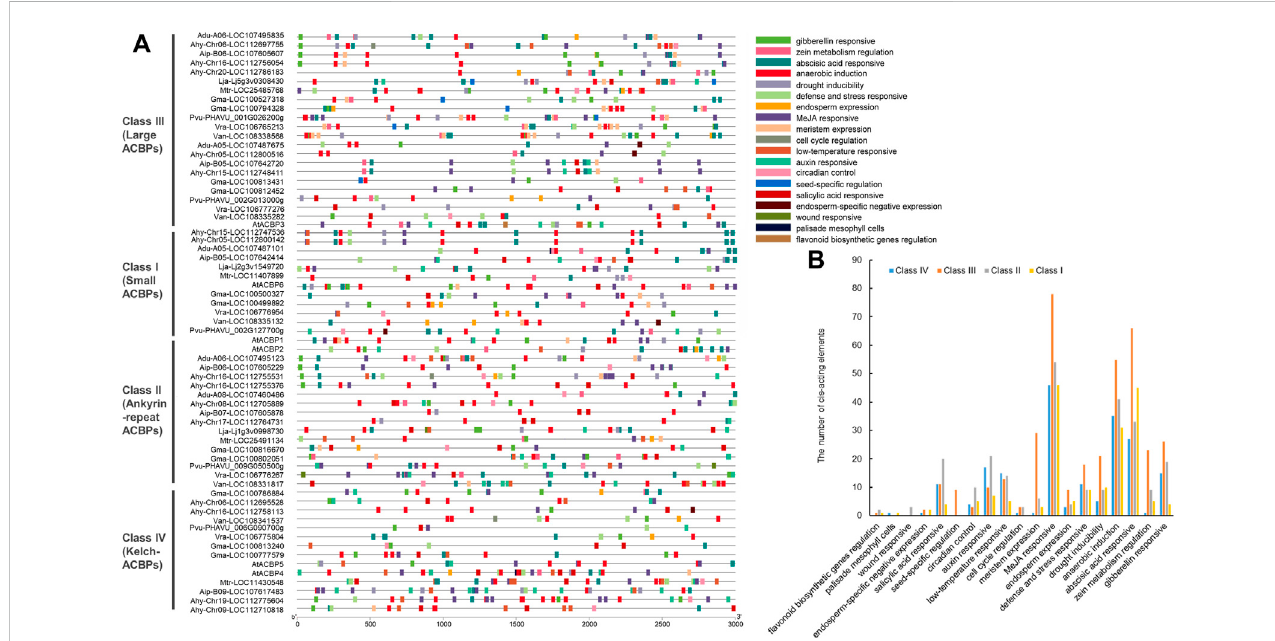
FIGURE 4 Cis-acting elements in the promoter regions of legume ACBPs genes. (A) Promoter sequences ( − 3,000 bp) of legume ACBPs genes were analyzed by PlantCARE. The upstream length to the translation start site can be inferred according to the scale at the bottom. The colored boxes indicate different cis- acting elements that represent the corresponding biological functions. (B) The number of cis-acting elements with different functions in each subgroup of legume ACBPs.